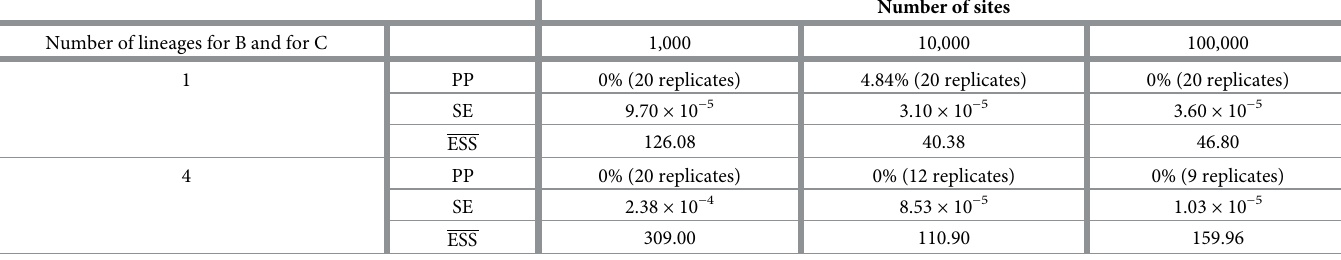
Number of lineages for B and for